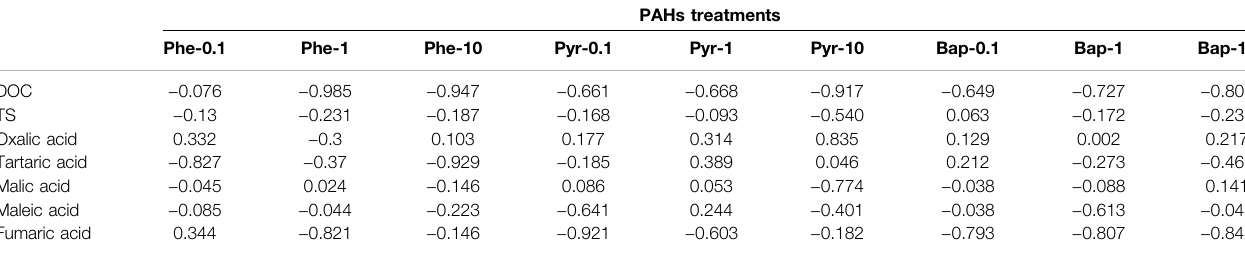
TABLE 4 | The correlation between the residual amounts of PAHs and components of root exudates in hydroponic solution.